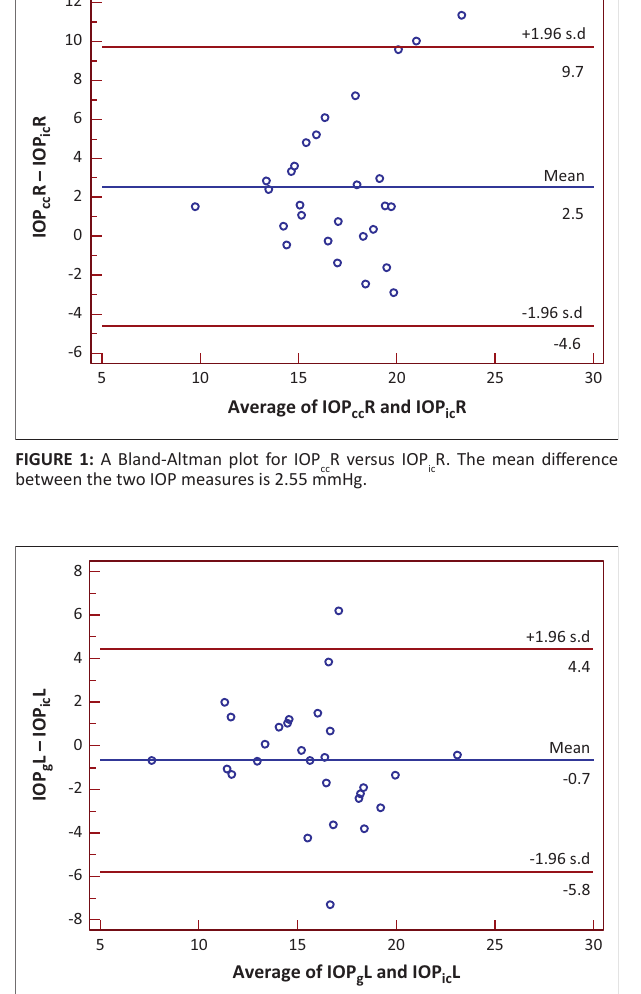
L versus IOP L is shown. The mean g ic